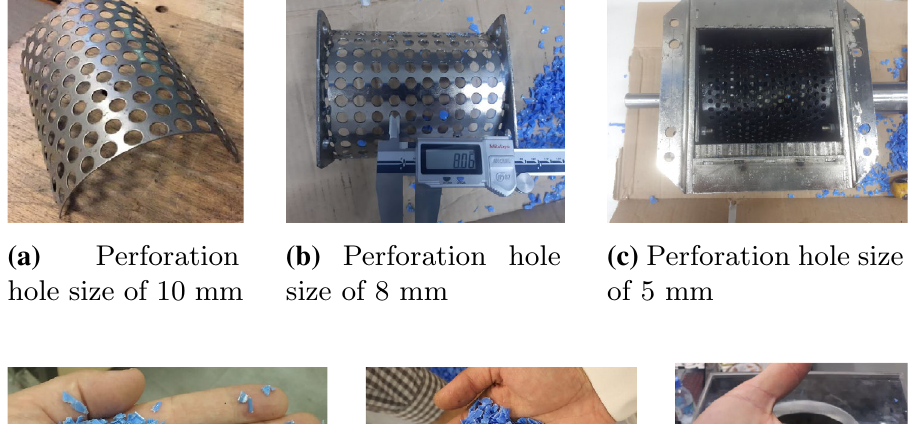
Fig. 14 Plastic flakes of varying sizes